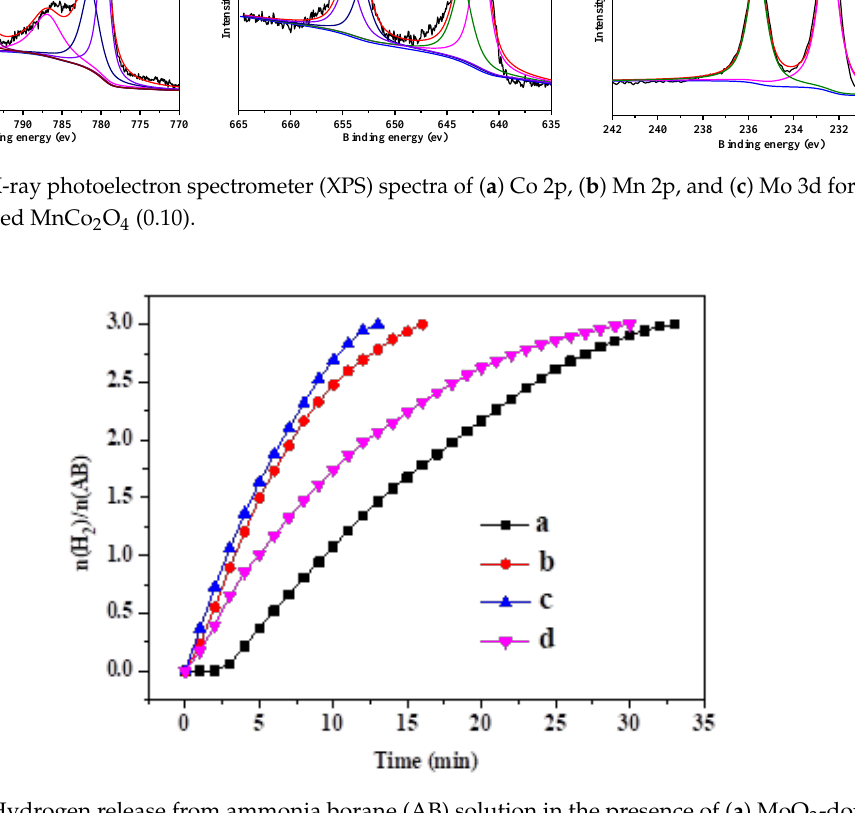
Figure 6. Hydrogen release from ammonia borane (AB) solution in the presence of ( a ) MoO 3 -doped MnCo 2 O 4 (0), ( b ) MoO 3 -doped MnCo 2 O 4 (0.04), ( c ) MoO 3 -doped MnCo 2 O 4 (0.10), and ( d ) MoO 3 -doped MnCo 2 O 4 (0.12).